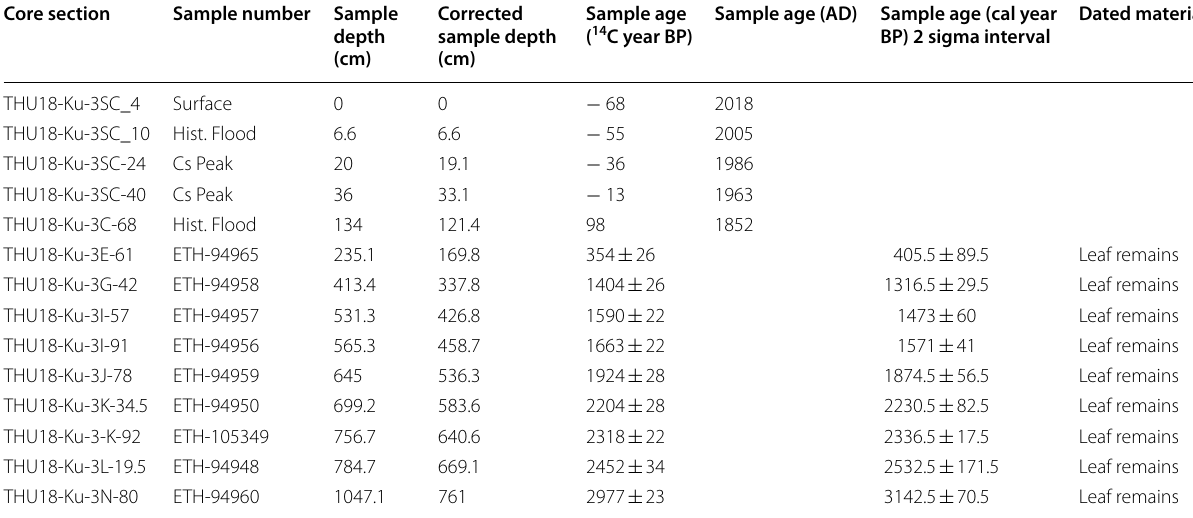
Summary of dating horizons such as historical flood events, 137 Cs peaks and radiocarbon dates from leaf remains used for the age model of sediment core THU18-Ku-03 (position in Fig. 1b). The total core depth and the event-deposit-corrected depth is given. The core-to-core correlation that illustrates the position of the flood events and the 137 Cs peaks is shown in Additional file 1: Fig.